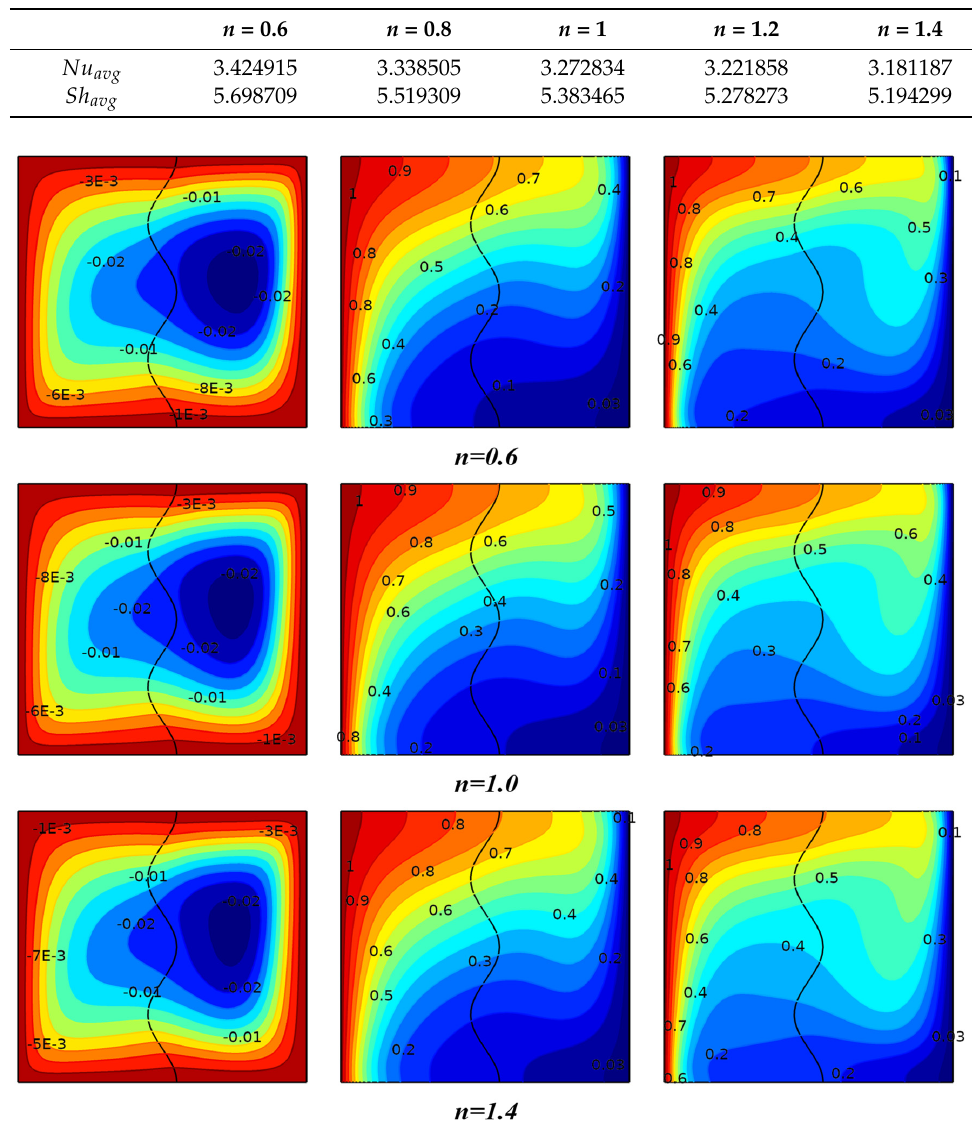
Figure 7. Streamlines (column 1), isotherms (column 2), and isoconcentration (column 3).